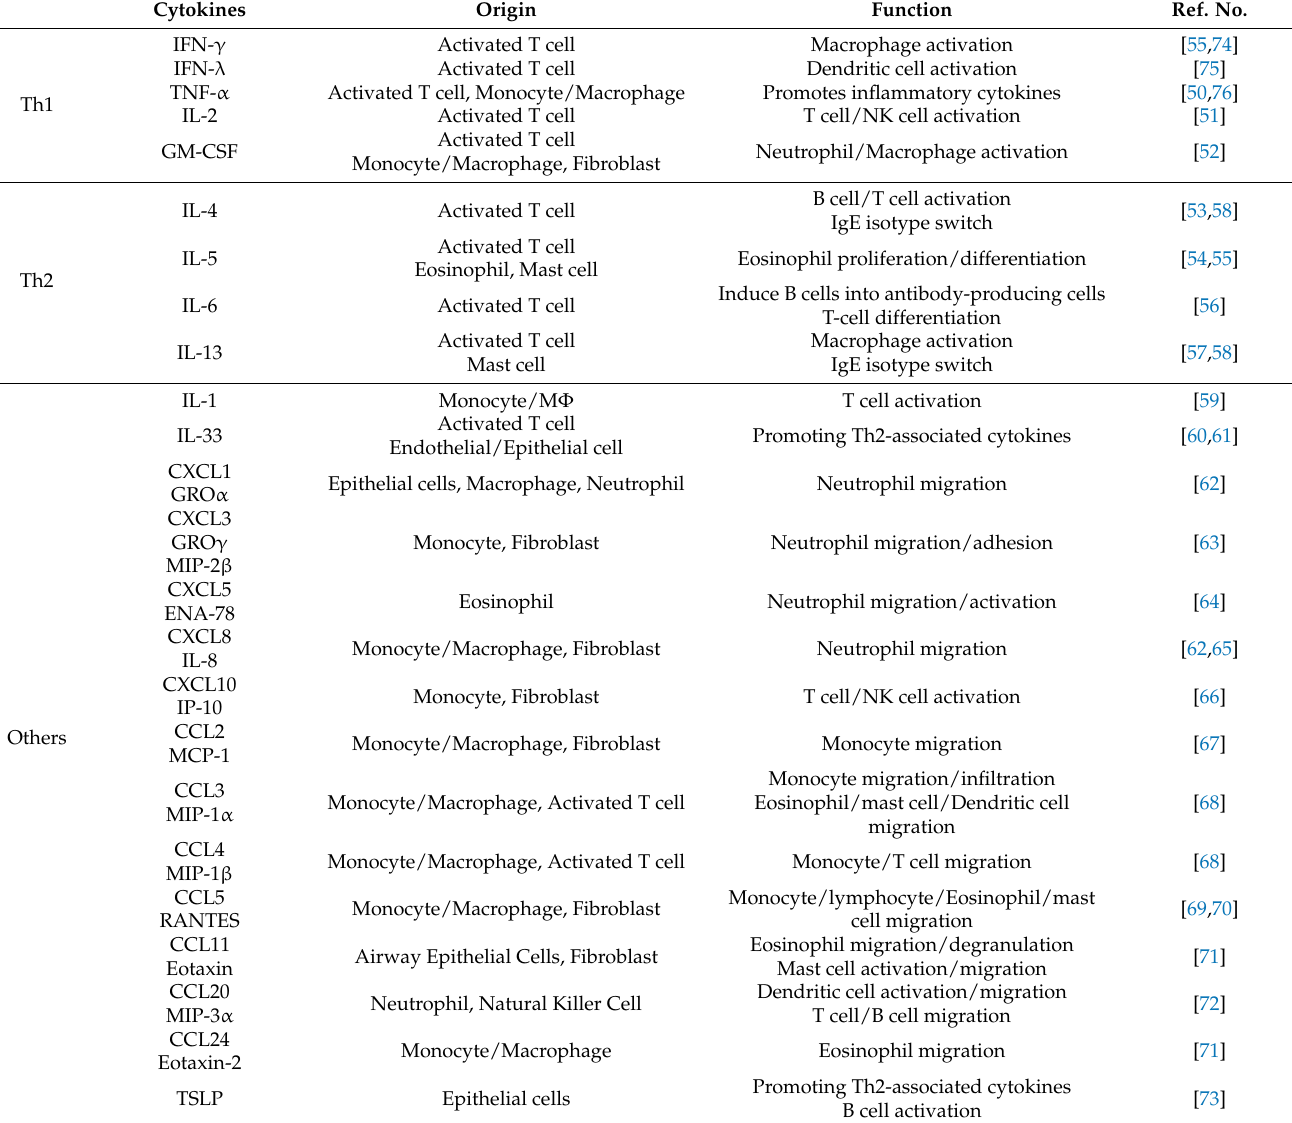
Table 1. Relationships among various cytokines, origins, and functions.